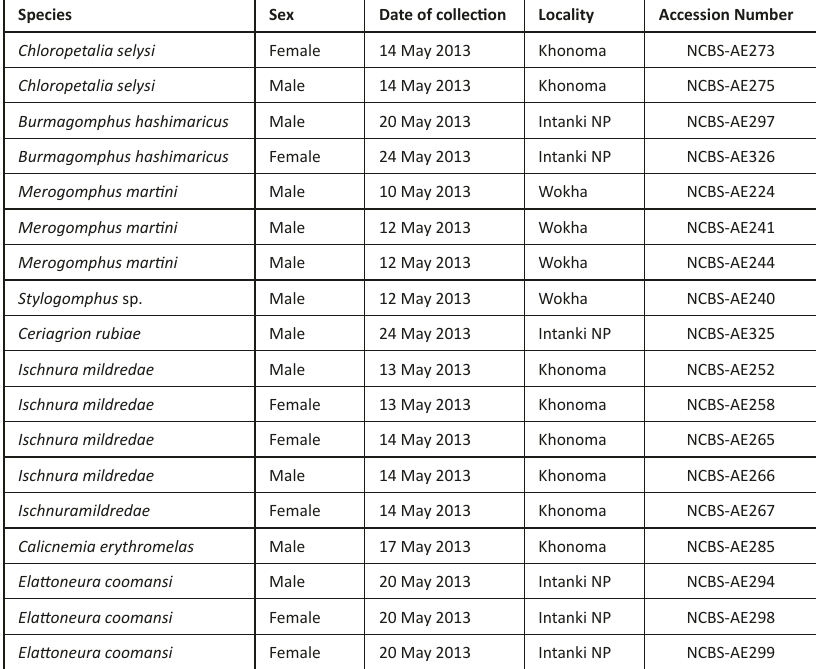
Merogomphus martini